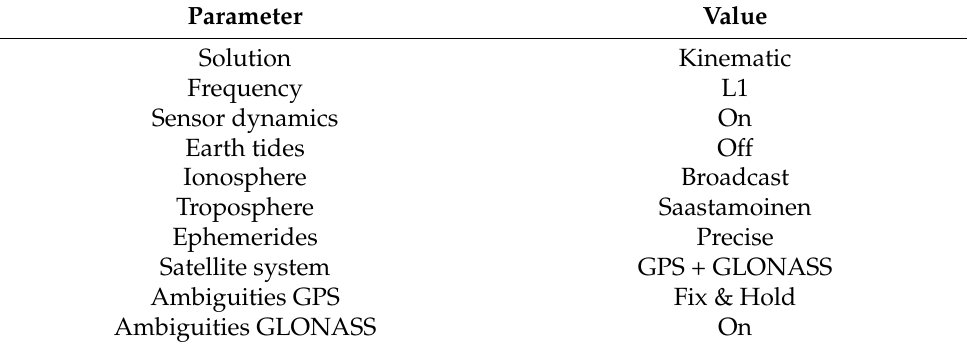
Table 2. Parameter settings for the post-processing using